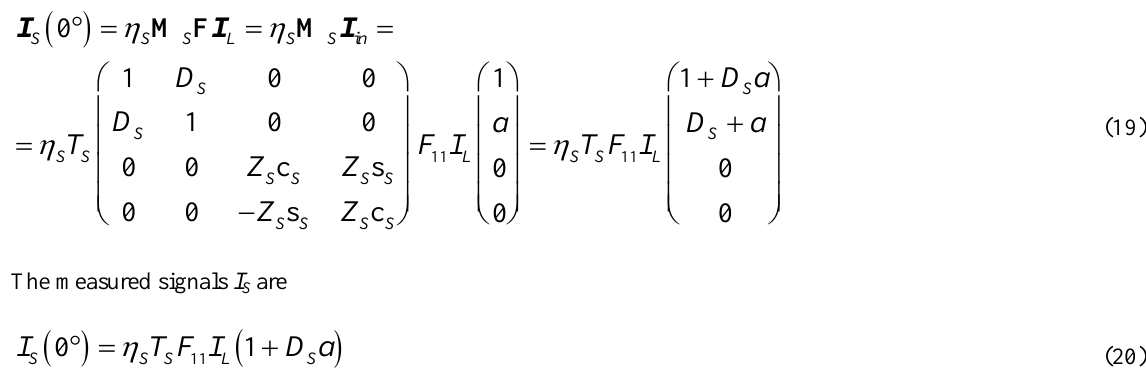
) and reflected ( I ) channels, alias I , after the polarising T R S . O